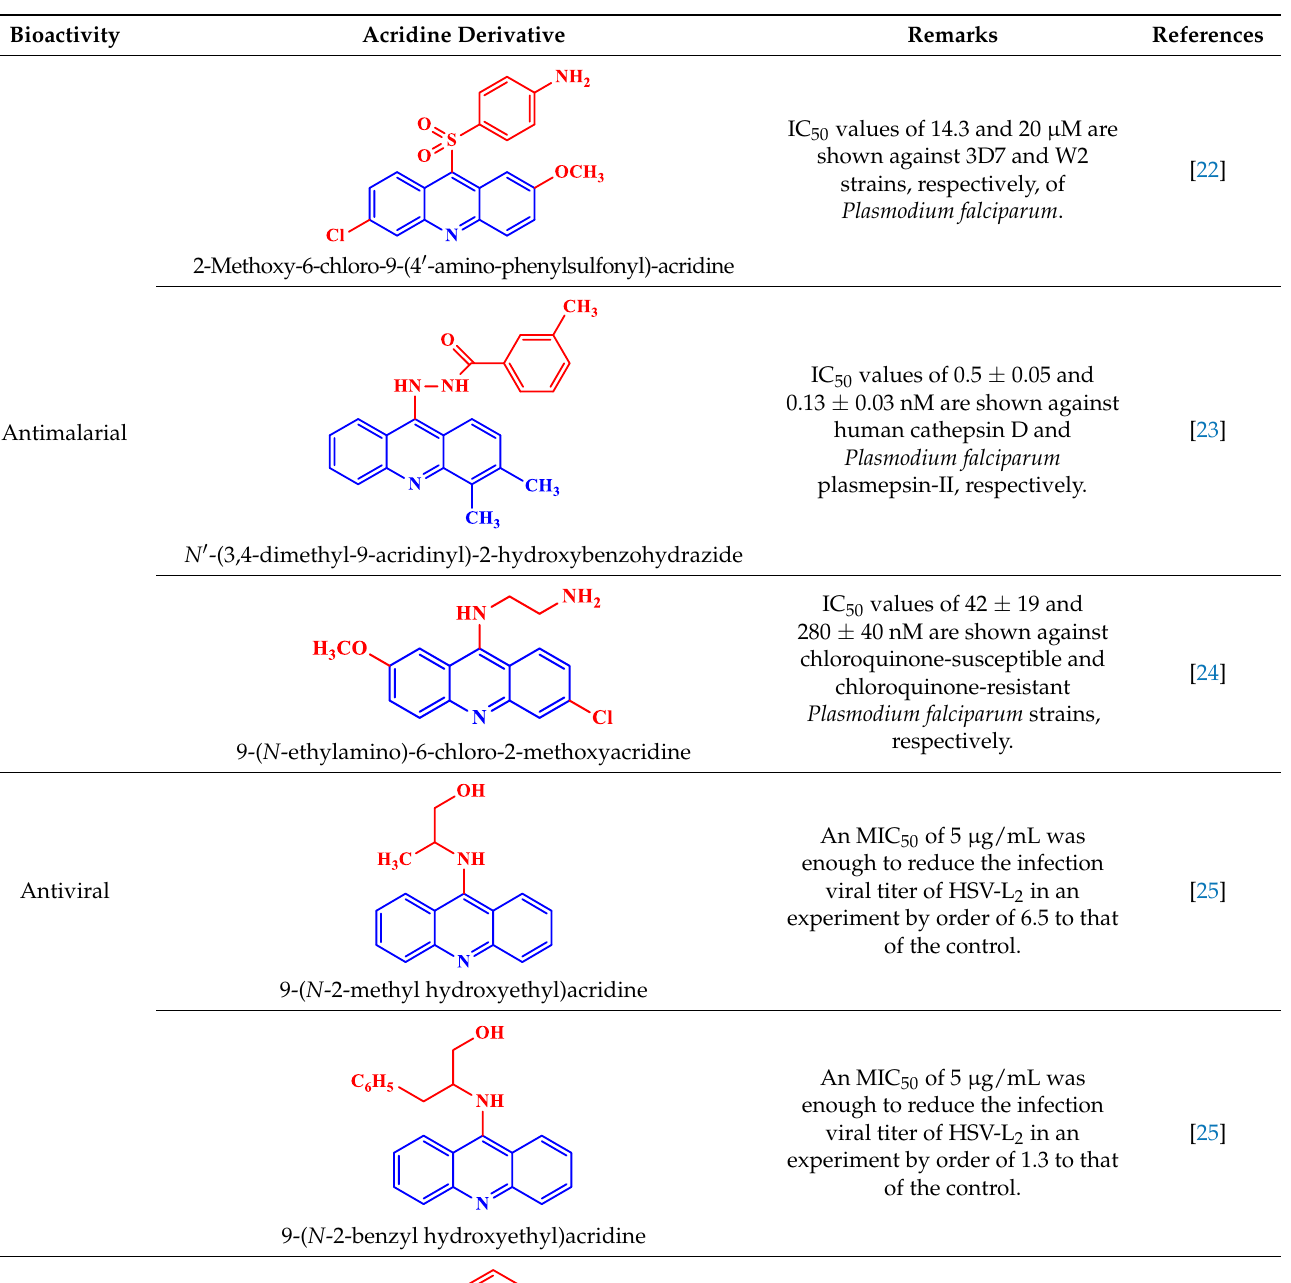
Table 1. Several pharmaceutically important acridine derivatives and their chemical